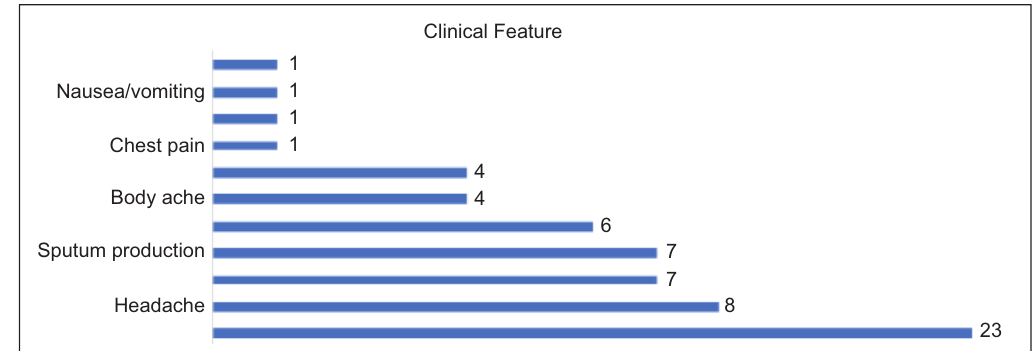
Figure 1: Clinical features of COVID-19 in renal transplant recipients.